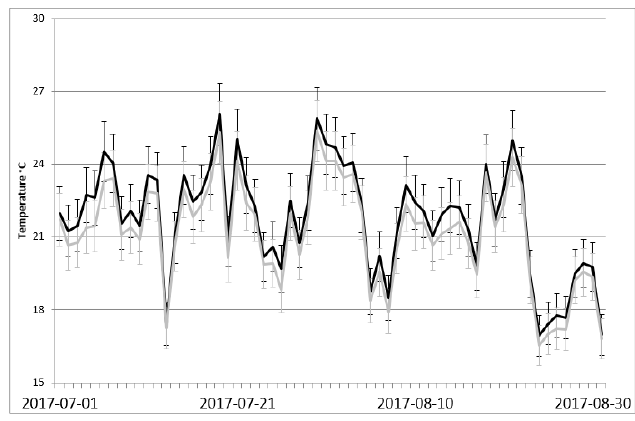
Figure 5. Daily average near-surface air temperature (°C) for control and treatment across all sites for the 2017 summer season. Error bars signify 5% of the measured value, which is consistent with the detection limits of the instrumentation [6] .